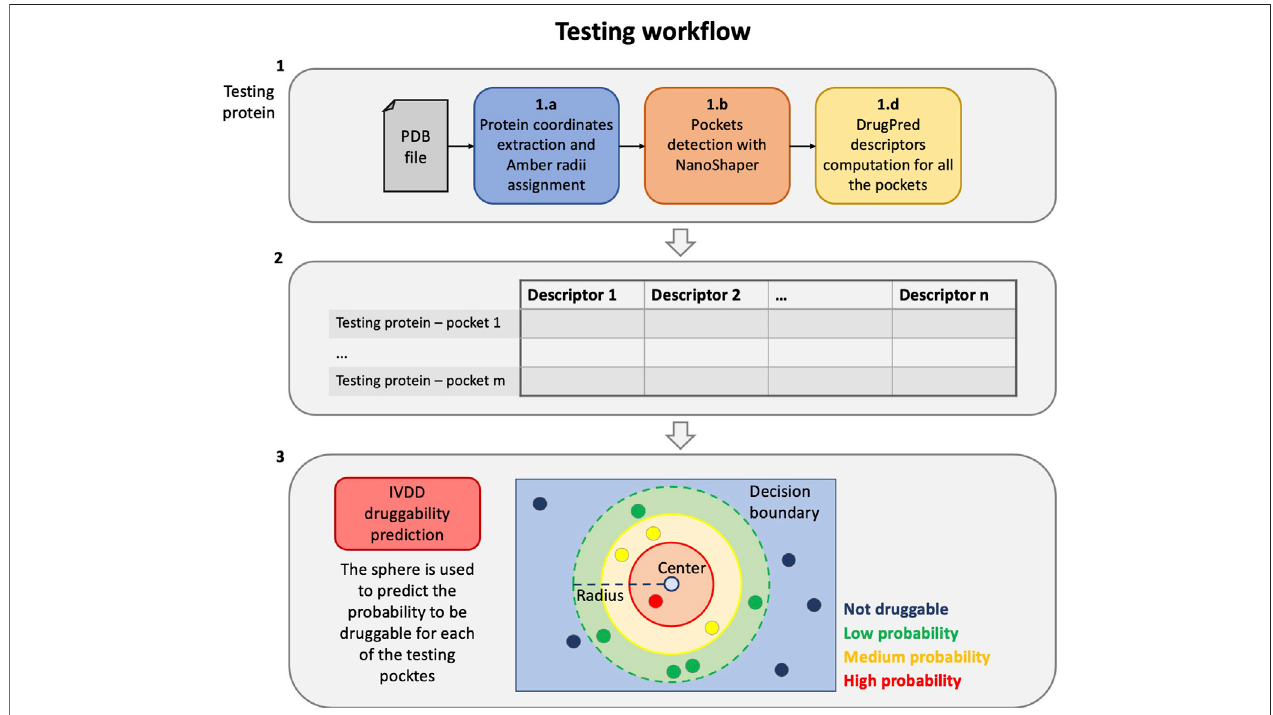
FIGURE 2 | Testing work fl ow. From the protein PDB fi le to the druggability prediction with the trained IVDD.